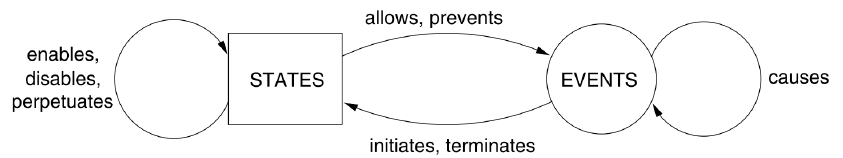
Figure 18. Kinds of causal relationships between states and events [171] .